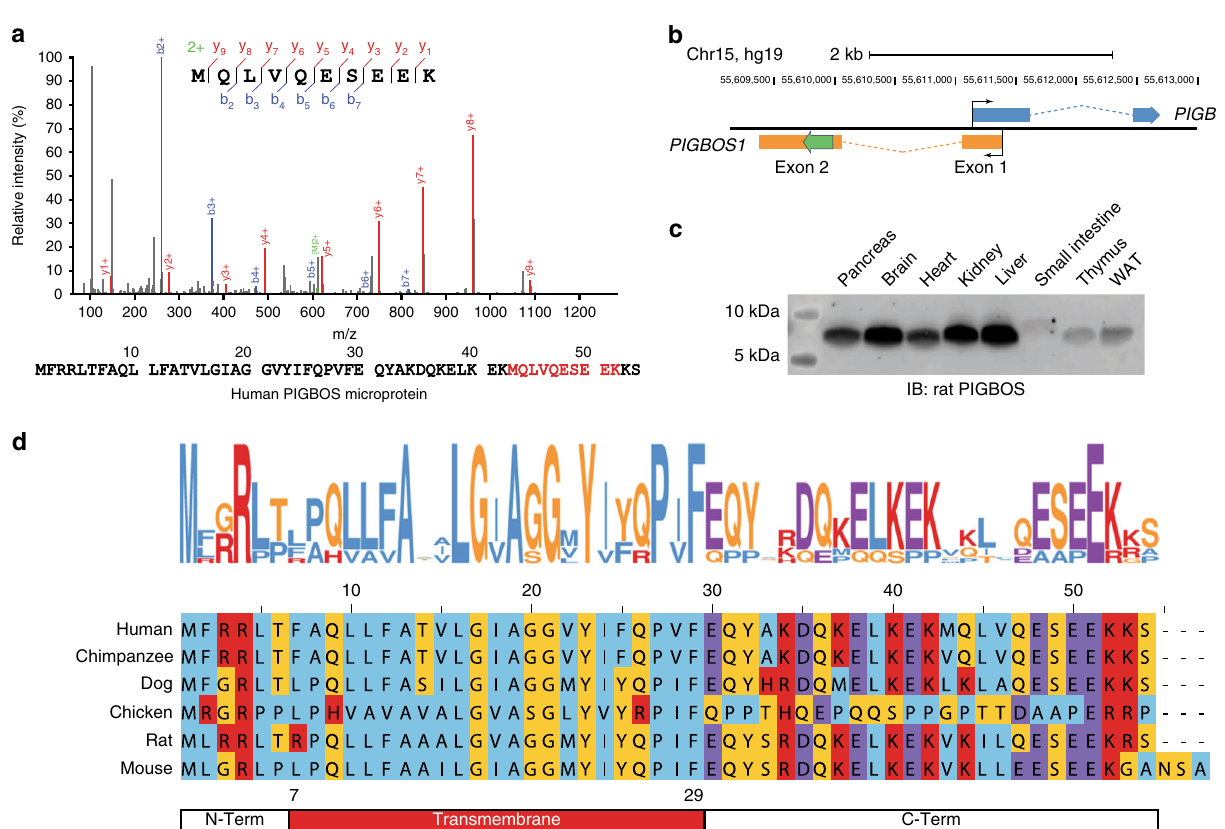
Fig. 1 PIGBOS is a conserved microprotein. a Detection of a unique PIGBOS tryptic peptide by proteomics (MS/MS spectrum as shown) and the entire 54 amino acid human PIGBOS microprotein with detected tryptic peptide (red). b PIGBOS1 gene contains two exons and is located on the opposite strand of the PIGB gene on chromosome 15. The PIGBOS protein coding sequence (CDS) in exon 2 is highlighted in green. c Western blot of rat tissues detects endogenous PIGBOS microprotein expression. d A logo plot generated from the sequence alignment of PIGBOS microprotein from multiple species reveals conserved amino acids including the transmembrane region between amino acids 7 – 29 (red) fl anked by a N-terminal region (N-Term, aa 1 – 6) and a C- terminal region (C-Term, aa 30 –